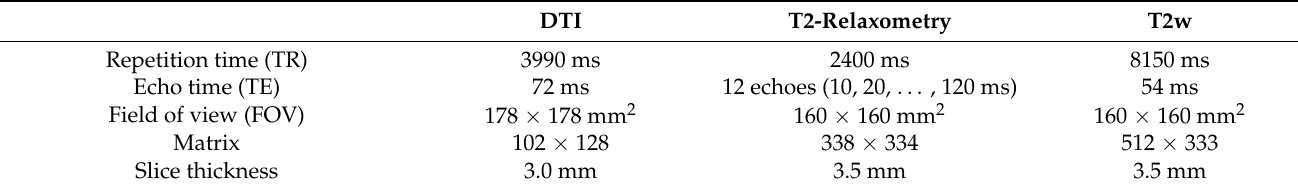
Table 1. Sequence